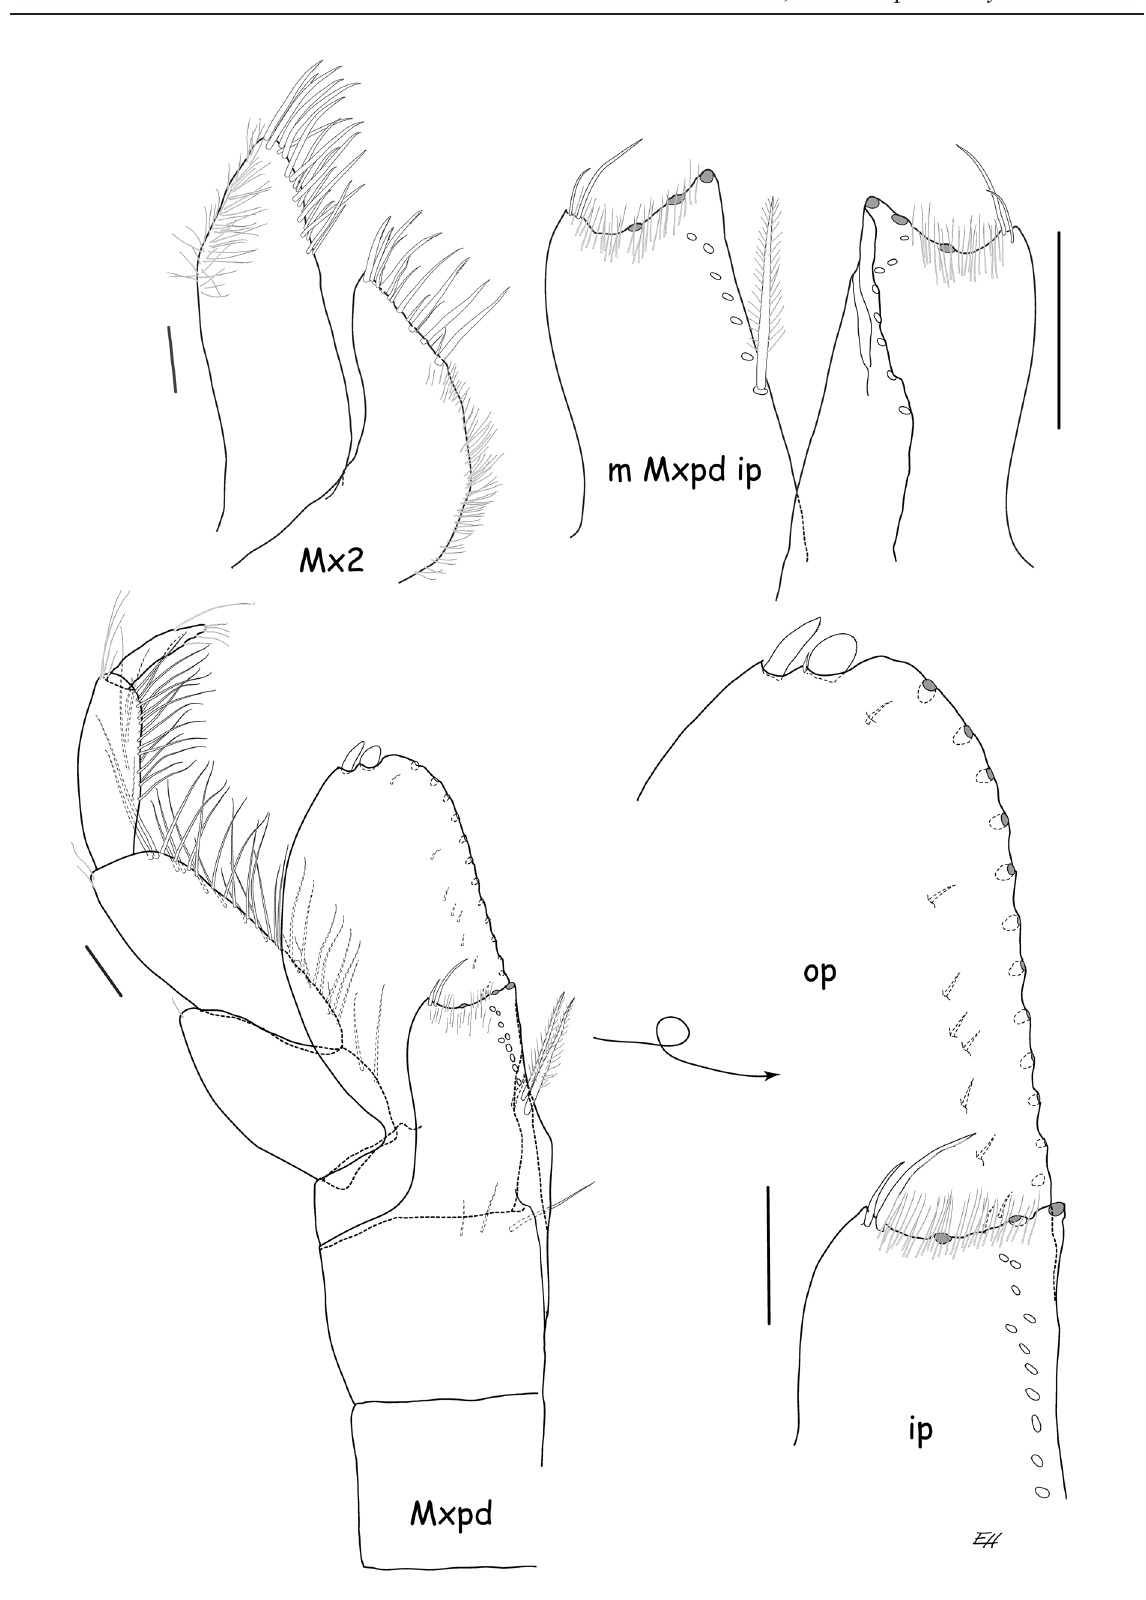
Fig. 13. Abyssorchomene patriciae sp. nov., holotype, ♀, 10.5 mm (NHM UK 2022.6); allotype, ♂, 7.5 mm (NHM UK 2022.7). Figures with sex not indicated are of female. Scale bars = 0.1